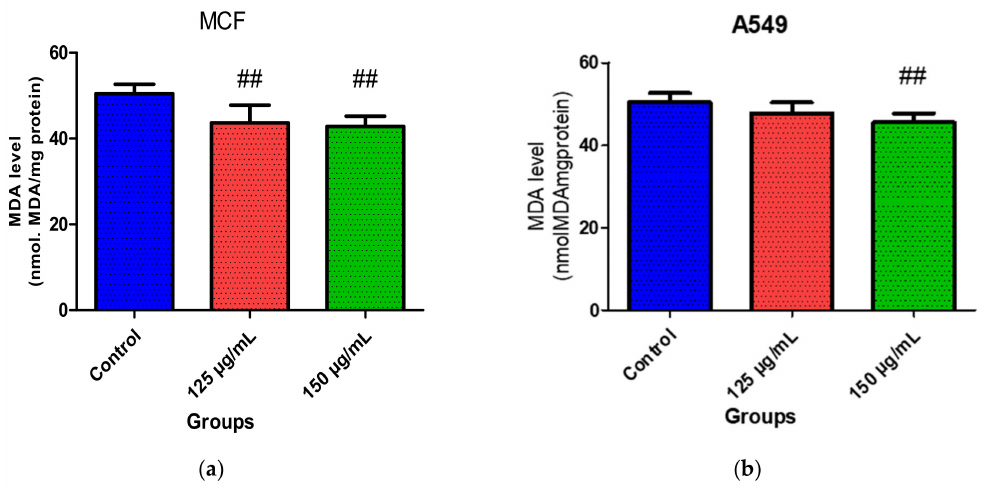
Figure 6. Effect of PUFA-rich extract from Chlorella sp. on MDA levels in ( a ) MCF-7 and ( b ) A549 cells after incubation for 48 h. Bars represent mean ± SEM. Values are statistically different at ## p < 0.05 vs. control.